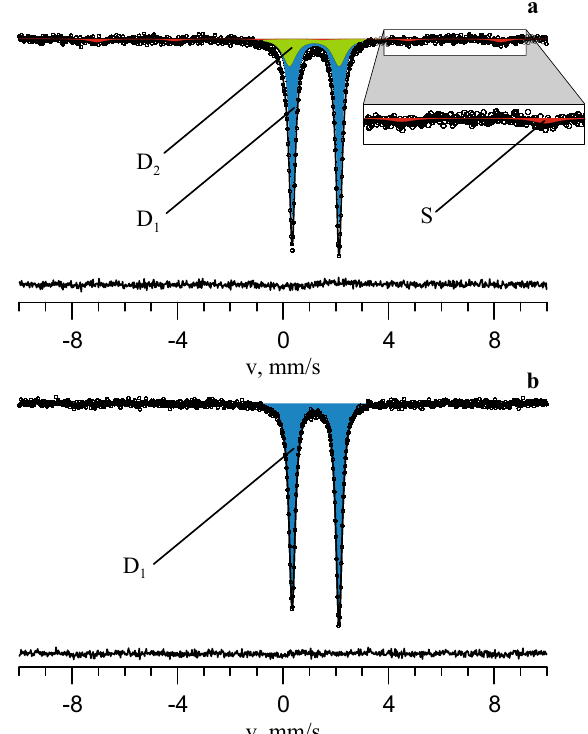
Figure 1. Mössbauer spectrum measured at room temperature of the mineral phase sampled from the bioreactor culture ( a ) and sterile control ( b ) on the 56th day of incubation. D 1 corresponds to Fe 2+ ions in the structure of initial siderite, D 2 —to Fe 2+ ions in the structure of biogenic siderite, S—to magnetically ordered phase.